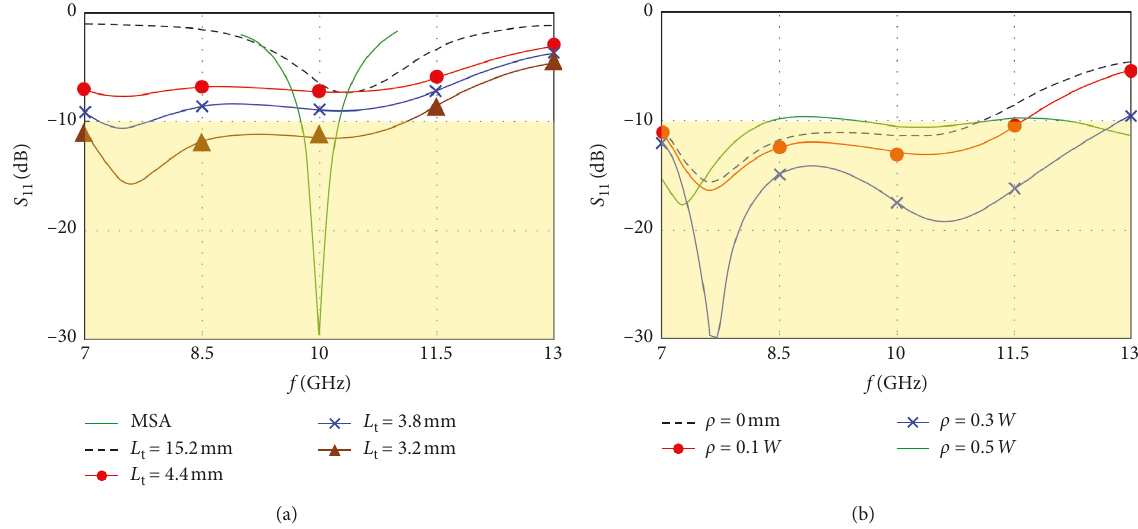
Figure 3: Printed antenna bandwidth widening study. (a) Ground plane reduction. (b) Patch bottom vertices rounding.